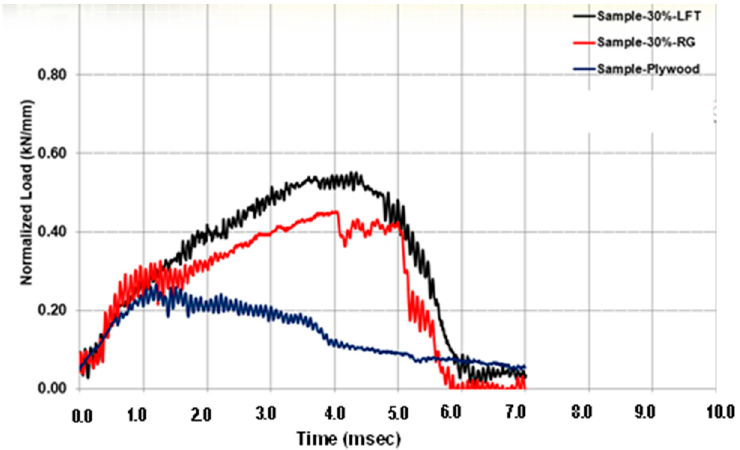
Figure 20. Comparison of LVI of recycled PP-GF, plywood and 30 wt% LFT PP-GF. Figure 21 represents the burn-off fibers in consolidated recyclate panels and indicates an average length of 5 mm.